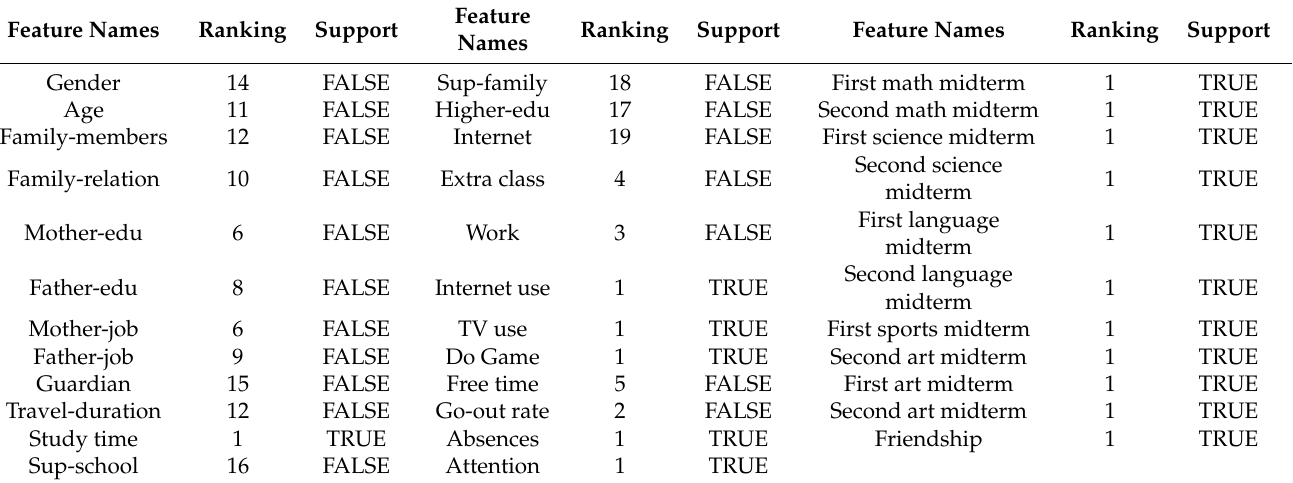
Table 2. The results of the Boruta algorithm.